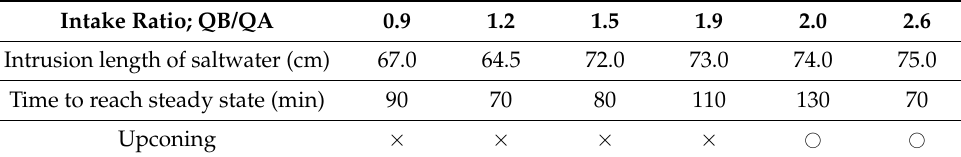
Figure 5. Results of experiments with the steady state at Step 3. Table 5. Results for Step 3.